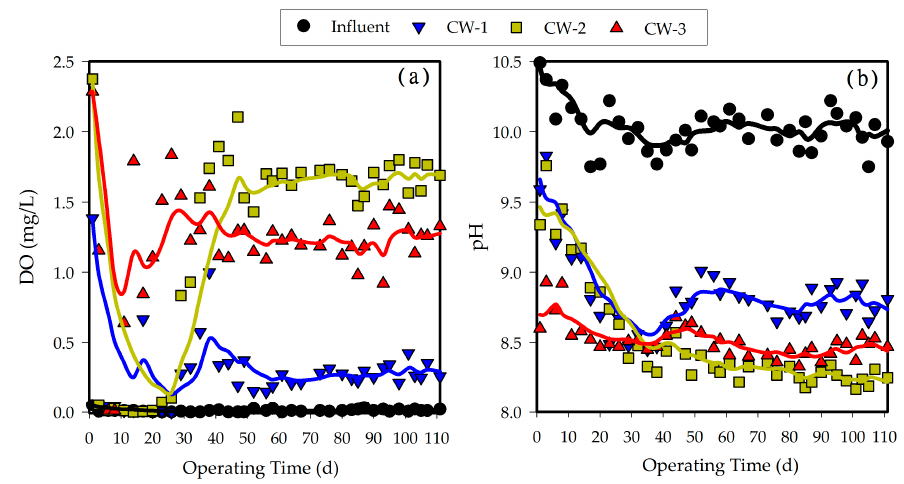
Figure 2. Dynamics of the concentration of DO and pH in influent and effluent. ( a ) DO; ( b ) pH.